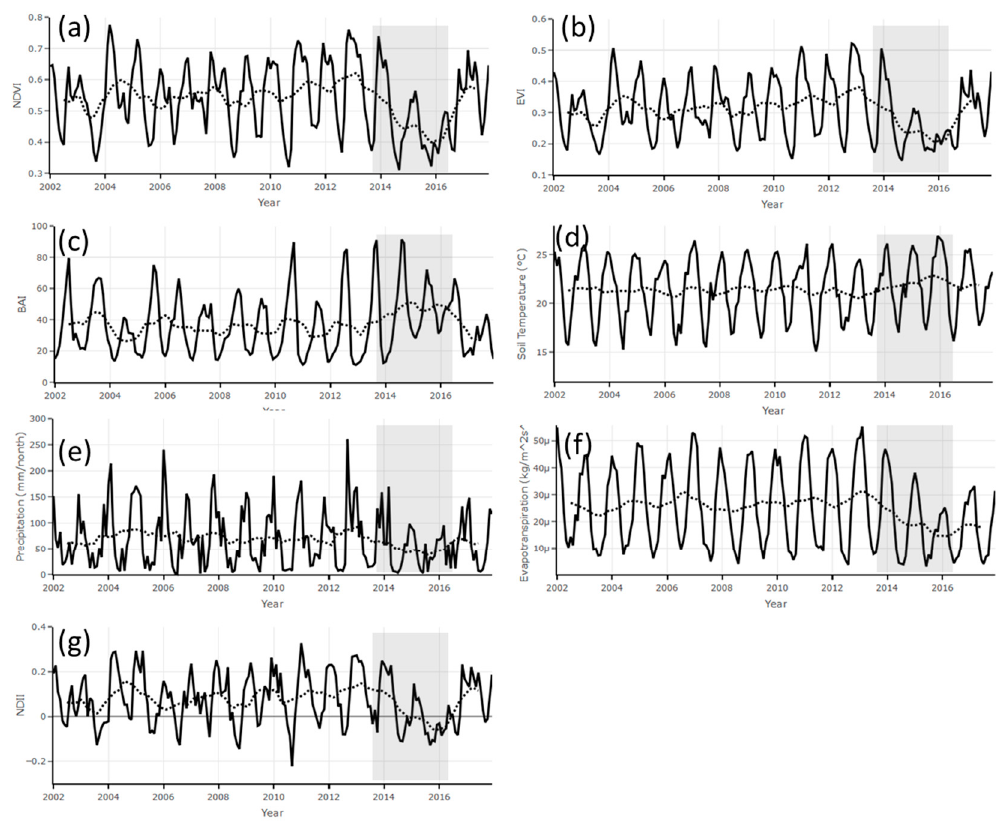
Figure 5. The monthly mean time series values of ( a ) NDVI, ( b ) Enhanced Vegetation Index (EVI), ( c ) Burned Area (BAI), and Modern Retrospective Analysis for the Research Application (MERRA-2) model soil temperature ( d ) and precipitation ( e ), Global Land Data Assimilation System (GILDAS) evapotranspiration ( f ) and Normalized Difference Infrared Index (NDII) ( g ). The dotted lines represent the 12-month smooth